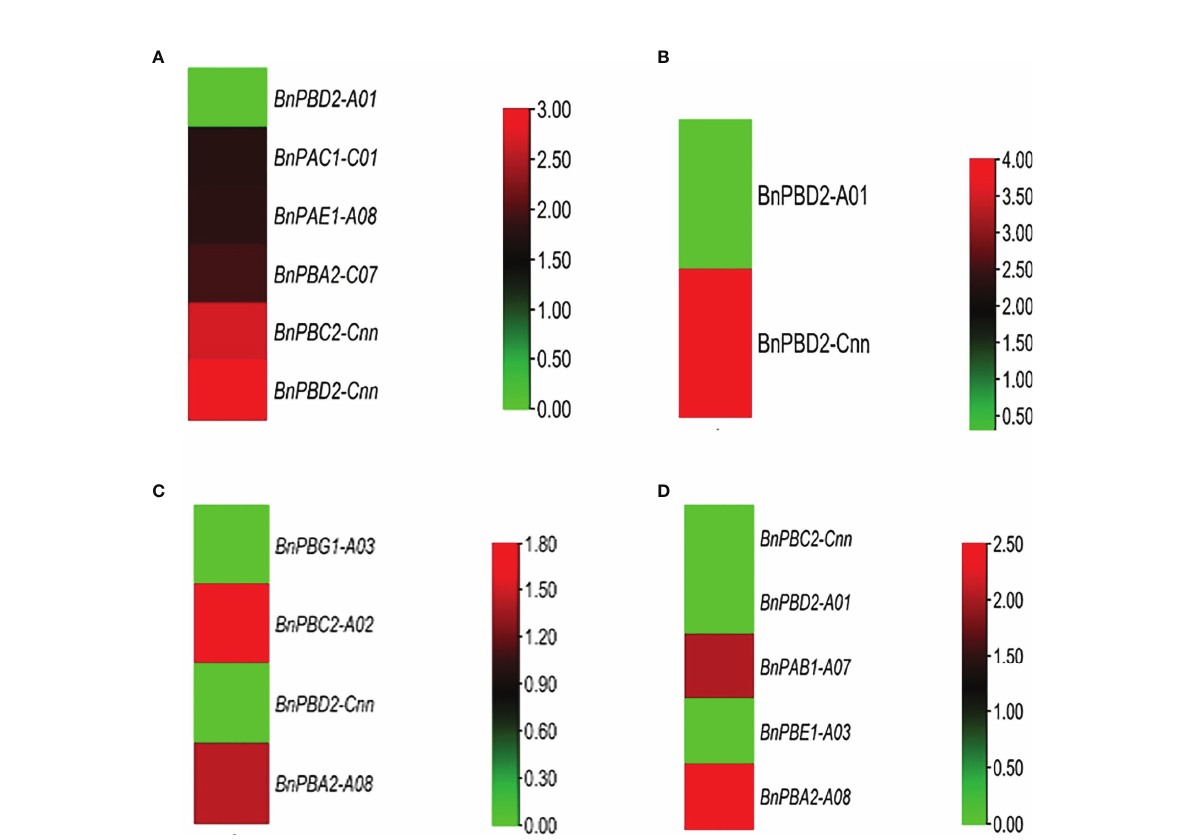
FIGURE 5 In silico expression pro fi ling of BnPA and BnPB genes at seedling and fl owering stages under abiotic stresses (A) cold and (B) drought and biotic stresses (C) Leptosphaeria maculans and (D) Sclerotinia sclerotiorum . The expression data of control and stress conditions are shown in the form of relative fold change